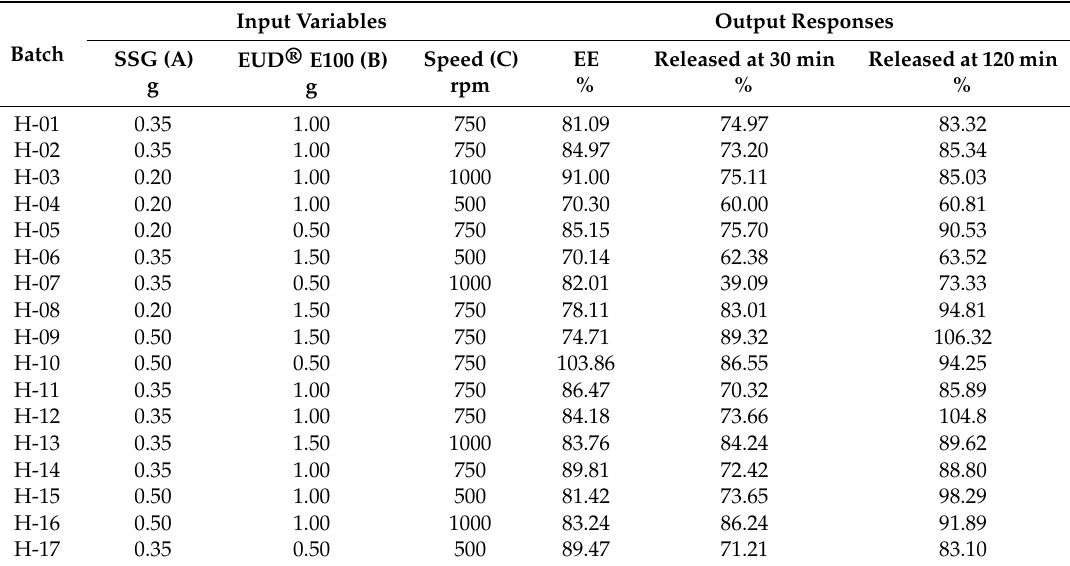
Table 2. Input variables and output responses monitored using a Box–Behnken design (BBD) for the manufacture of HCTZ microparticles.